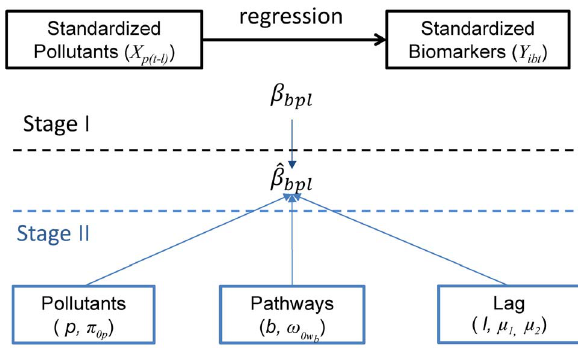
Fig. 1. Conceptual framework of the hierarchical modeling